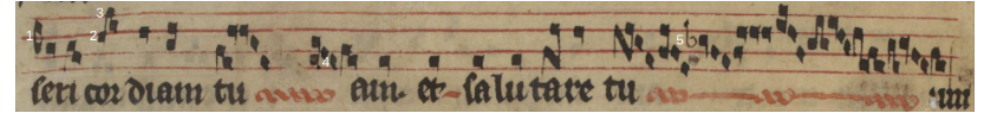
Figure 1. Staff image written in square notation of the Pa904 (Page 13) dataset. One instance for each class has been marked with a small white number in the picture. There are no instances for the classes F-clef, sharp- and natural-accidental in the example